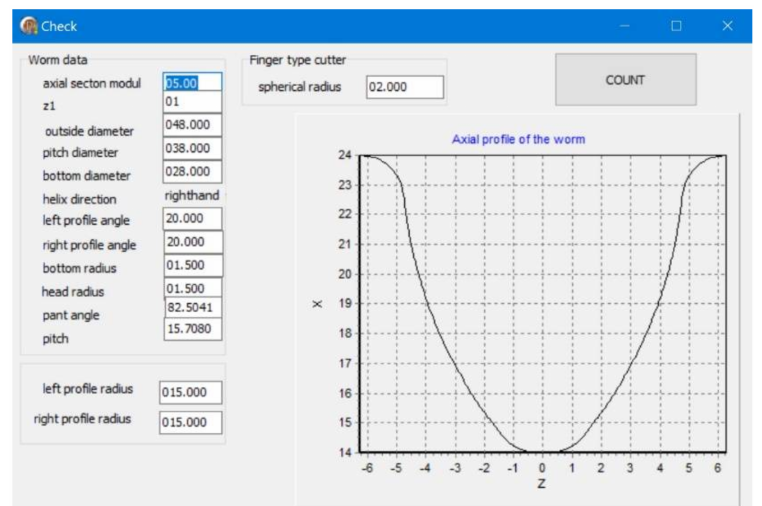
Figure 6. Authors’ program window: the parameters set and previously calculated, and a graphic showing the calculated axial profile of the worm for generating a control code for finishing the screw on a CNC machine